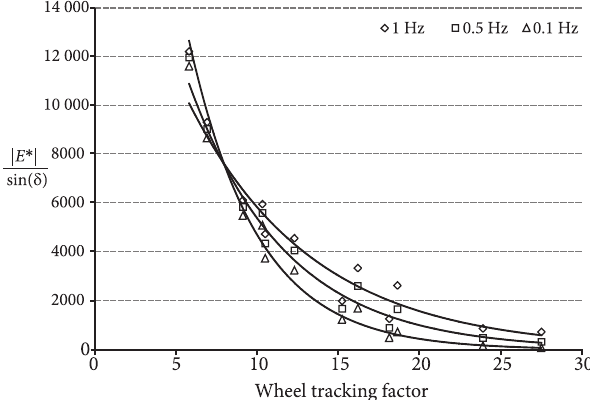
Fig. 11. Correlations between wheel the tracking factor